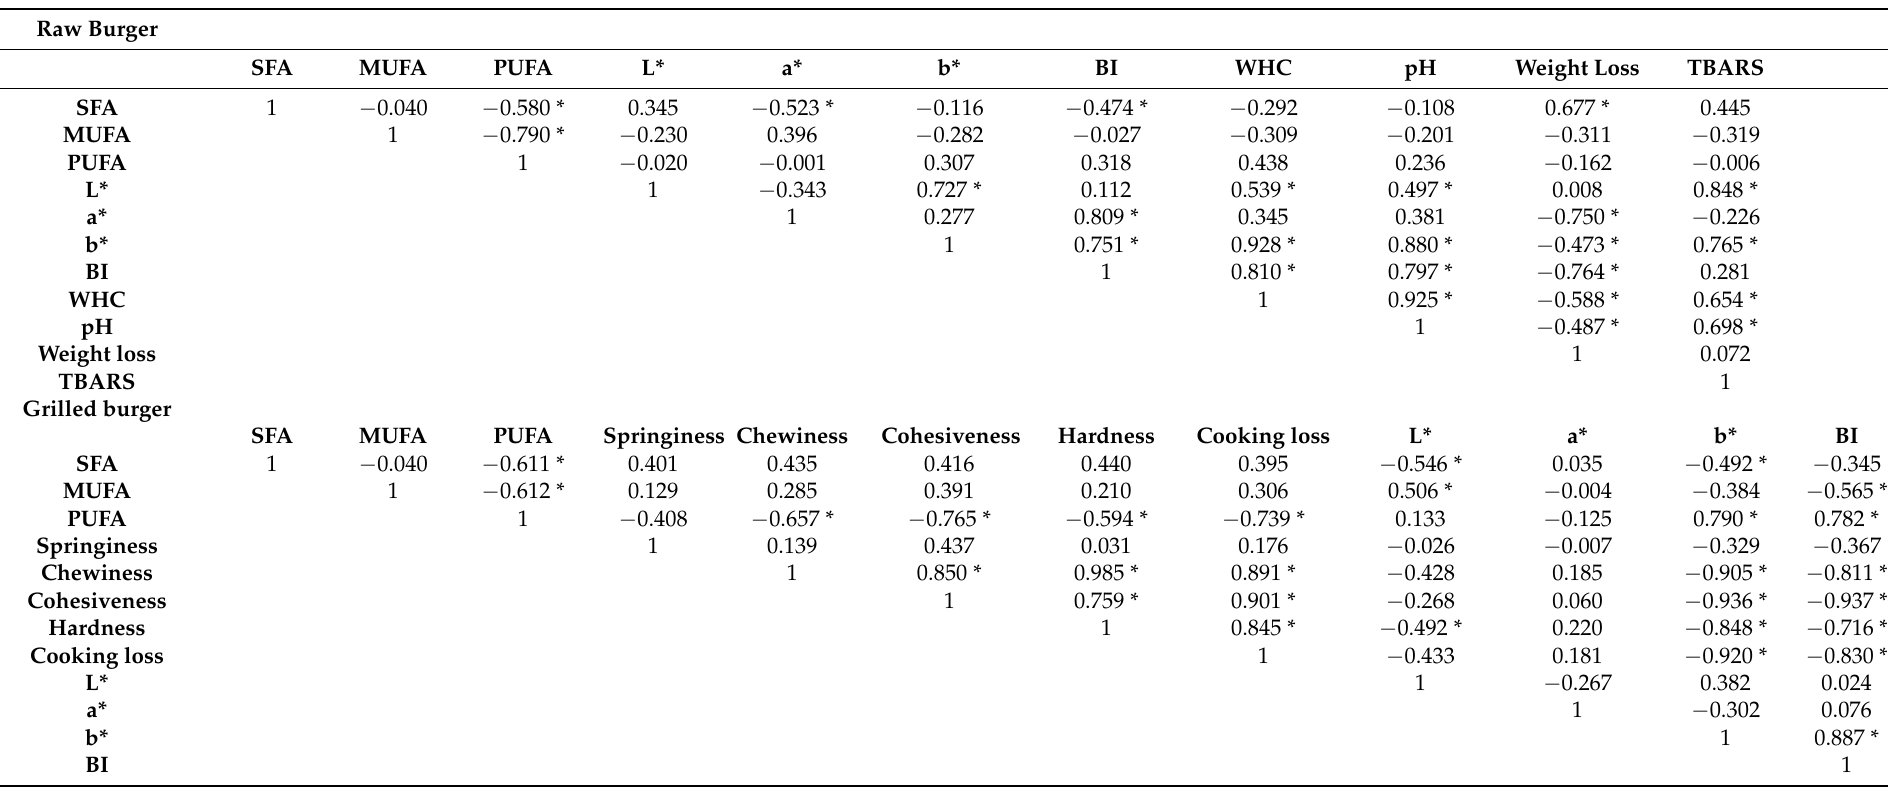
Table 8. Analysis of correlations among fatty acid profile (SFA, MUFA, and PUFA), color parameters (L*, a*, b*, and BI) and WHC, pH, weight and cooking loss, TBARS, and TPA parameters (springiness, chewiness, cohesiveness, and hardness) with raw and/or grilled